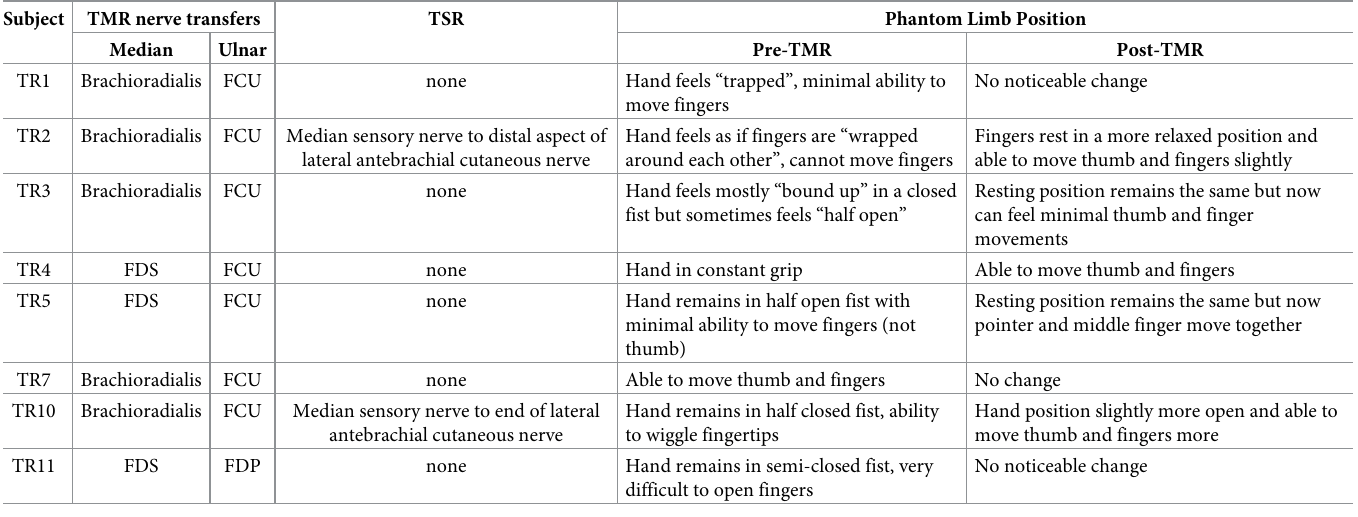
Table 4. Subject TMR and TSR